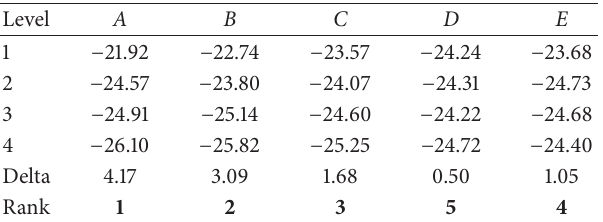
Table 7: S/N ratio response table for erosion rate.